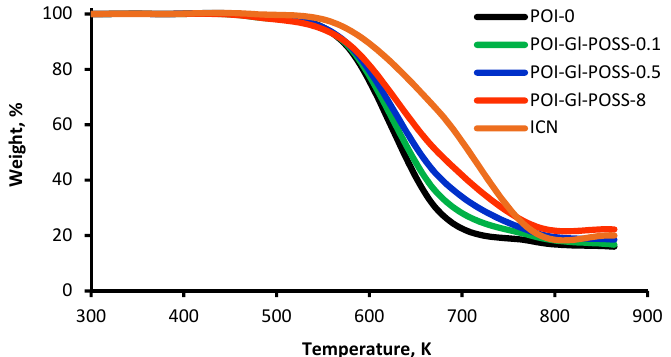
Figure 3. Thermogravimetric analysis curves of POI-Gl-POSS.